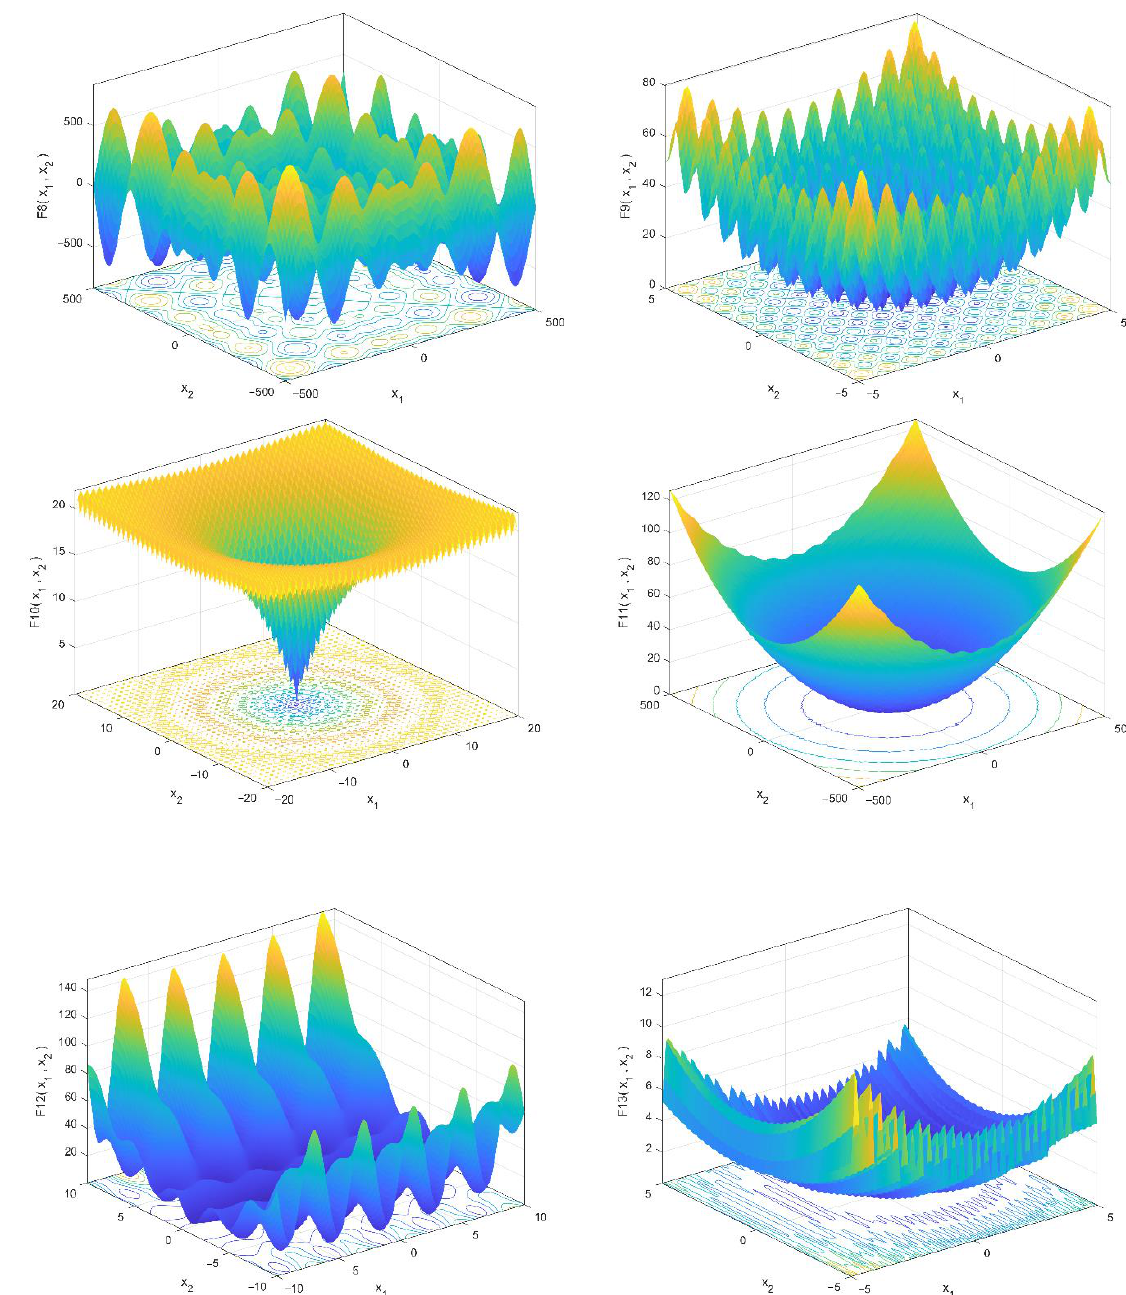
Figure 2. 3-D versions of unimodal benchmark functions.